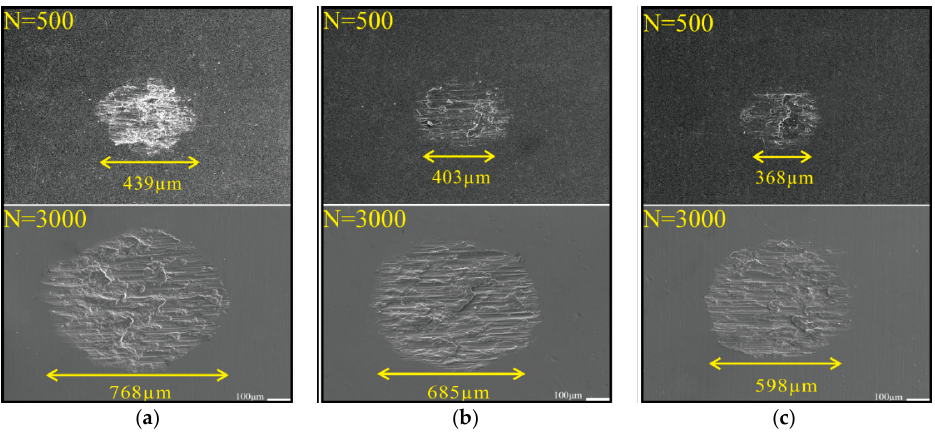
Figure 8. Micrographs of worn scars. ( a ) Untreated; ( b ) 5 J treated; ( c ) 7 J treated.